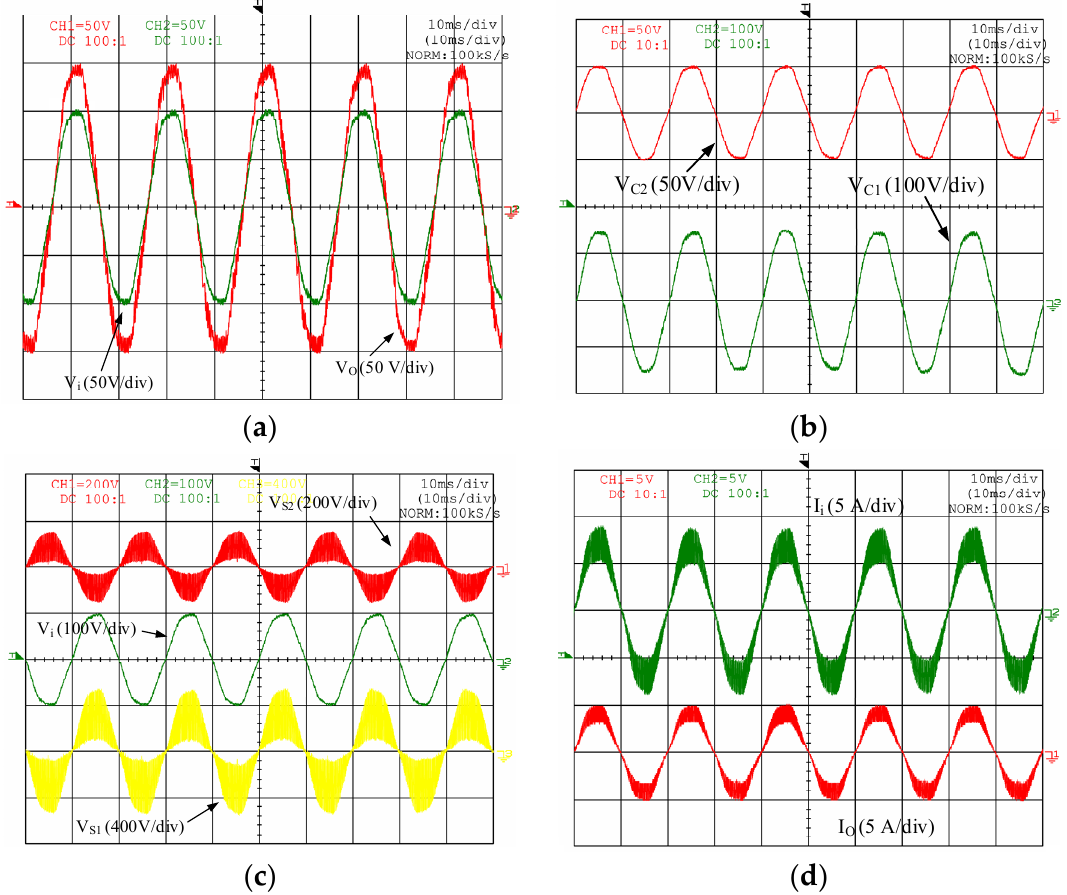
Figure 18. The experimental results of the proposed single-phased topology for Boost-in-phase operating mode: ( a ) input and output voltage waveforms, ( b ) capacitors’ voltages, ( c ) voltages of the power switches, and ( d ) input and output current waveforms.